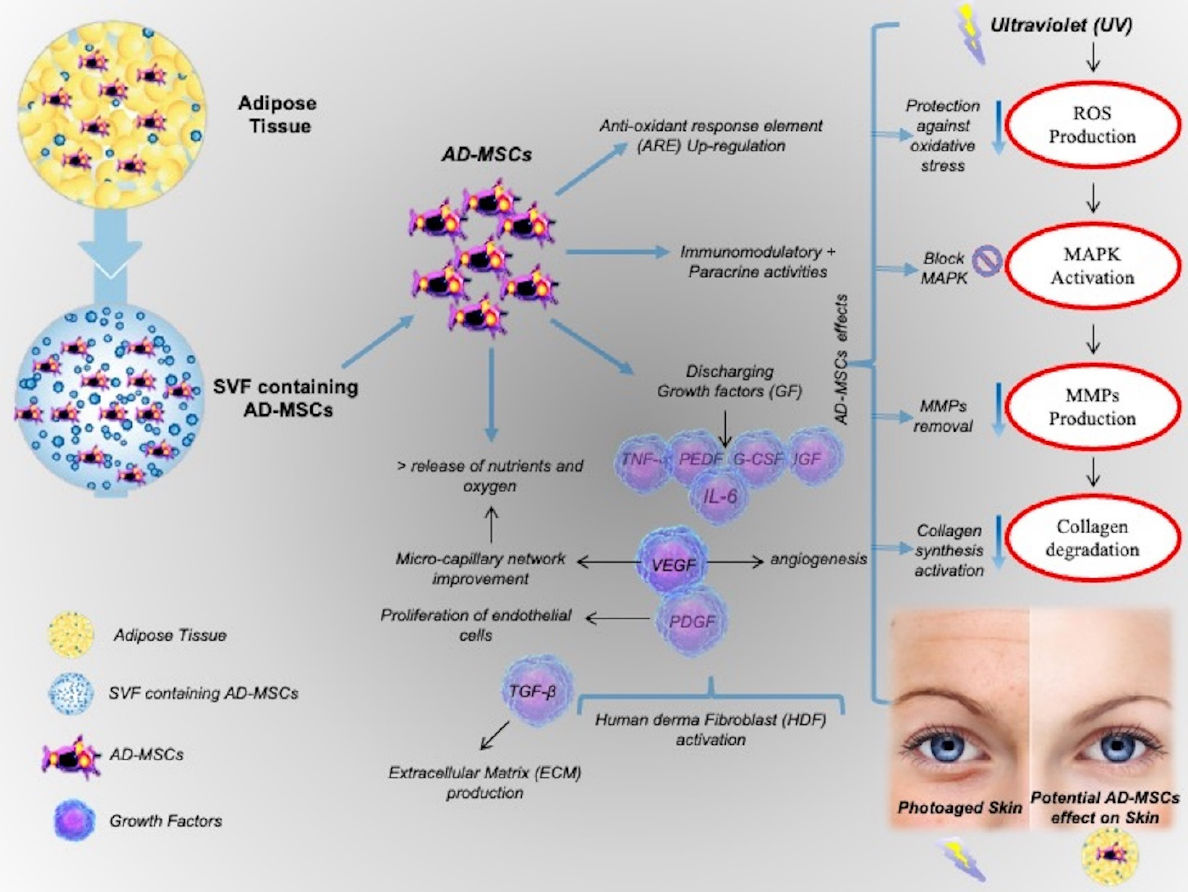
Figure 1. The protective role of AD-MSCs.